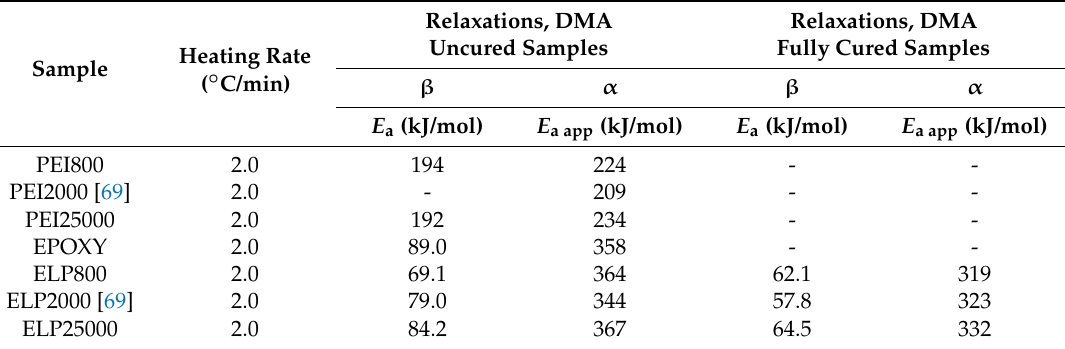
Figure 15. Relaxation map showing α -relaxation (circles) and β -relaxation (squares) obtained by DMA measurements at 2 °C/min. Open symbols: epoxy (black), PEI800 (pink), PEI25000 (blue). Filled symbols: uncured ELP800 (pink), uncured ELP25000 (blue). Table 5. Activation energy results obtained from dynamic mechanical (DMA) measurements for uncured and fully cured samples.